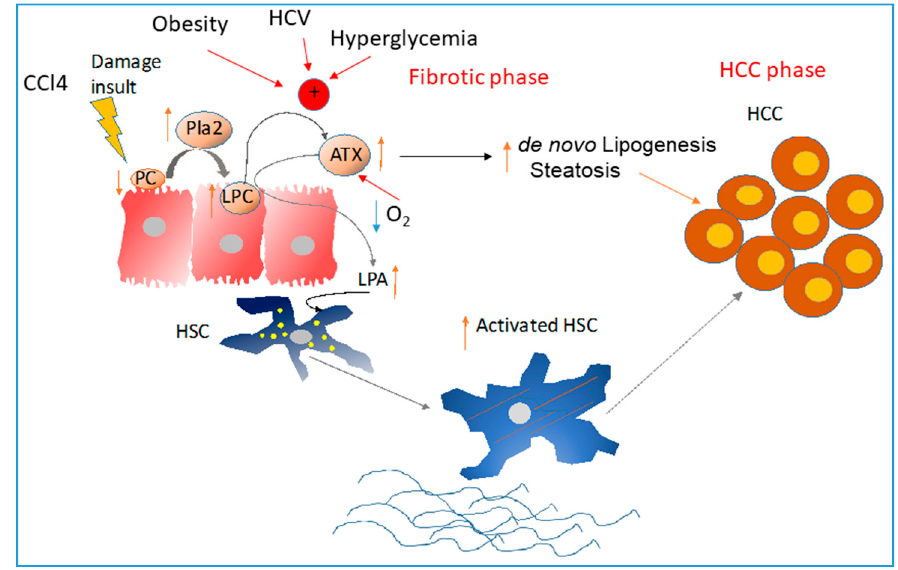
Figure 4. Hepatocyte specific ATX production driven by fat, glucose, phospholipids and Hepatitis C virus (HCV) infection can promote hepatic stellate cells (HSCs) activation, steatosis and hepatocellular carcinoma (HCC) growth.